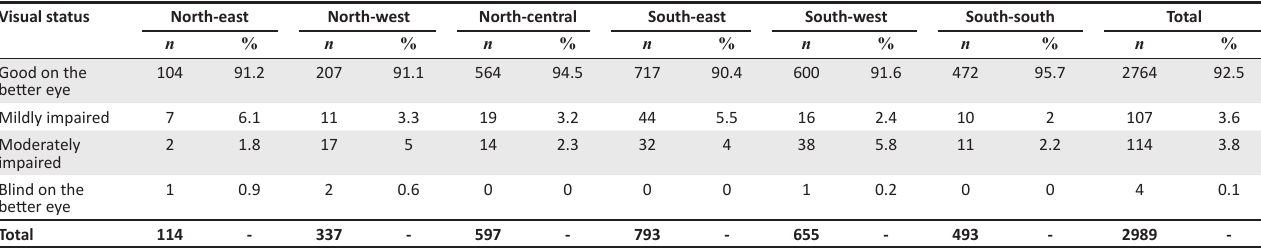
TABLE 2: Visual status of drivers by zone (presenting visual acuity in better eye). Visual status